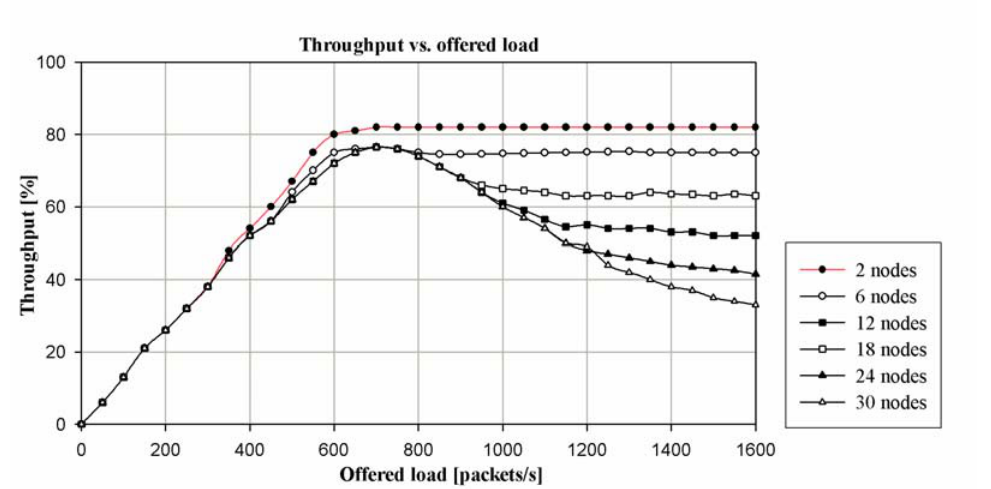
Figure 4. Throughput versus offered load for different number of nodes (load scenario 1).